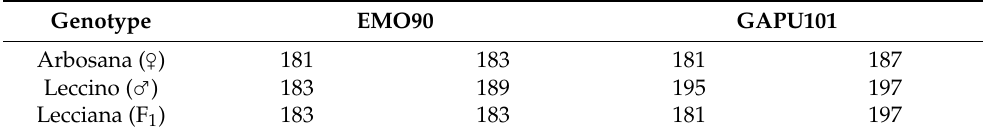
Table 1. Allelic profile of two polymorphic molecular markers for ‘Lecciana’ and for its parental cultivars Arbosana and Leccino. Allele size is reported in base pairs (bps).